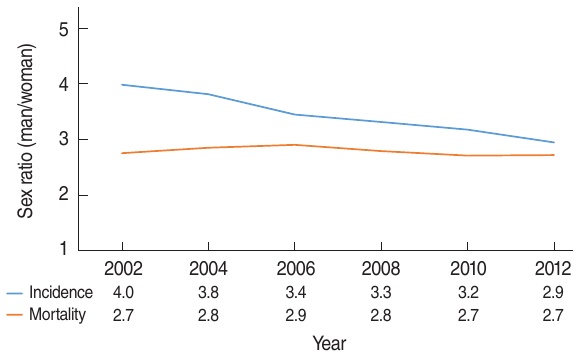
Figure 2. Trends of the histological proportion (%) of lung cancers in Koreans during 2002 and 2012. Source from Korea Central Cancer Registry (www.ncc.re.kr). M, men; W, women; Sq, squamous cell carcinoma; Ad, adenocarcinoma; Sm, small cell carcinoma; Lg large cell carcinoma.